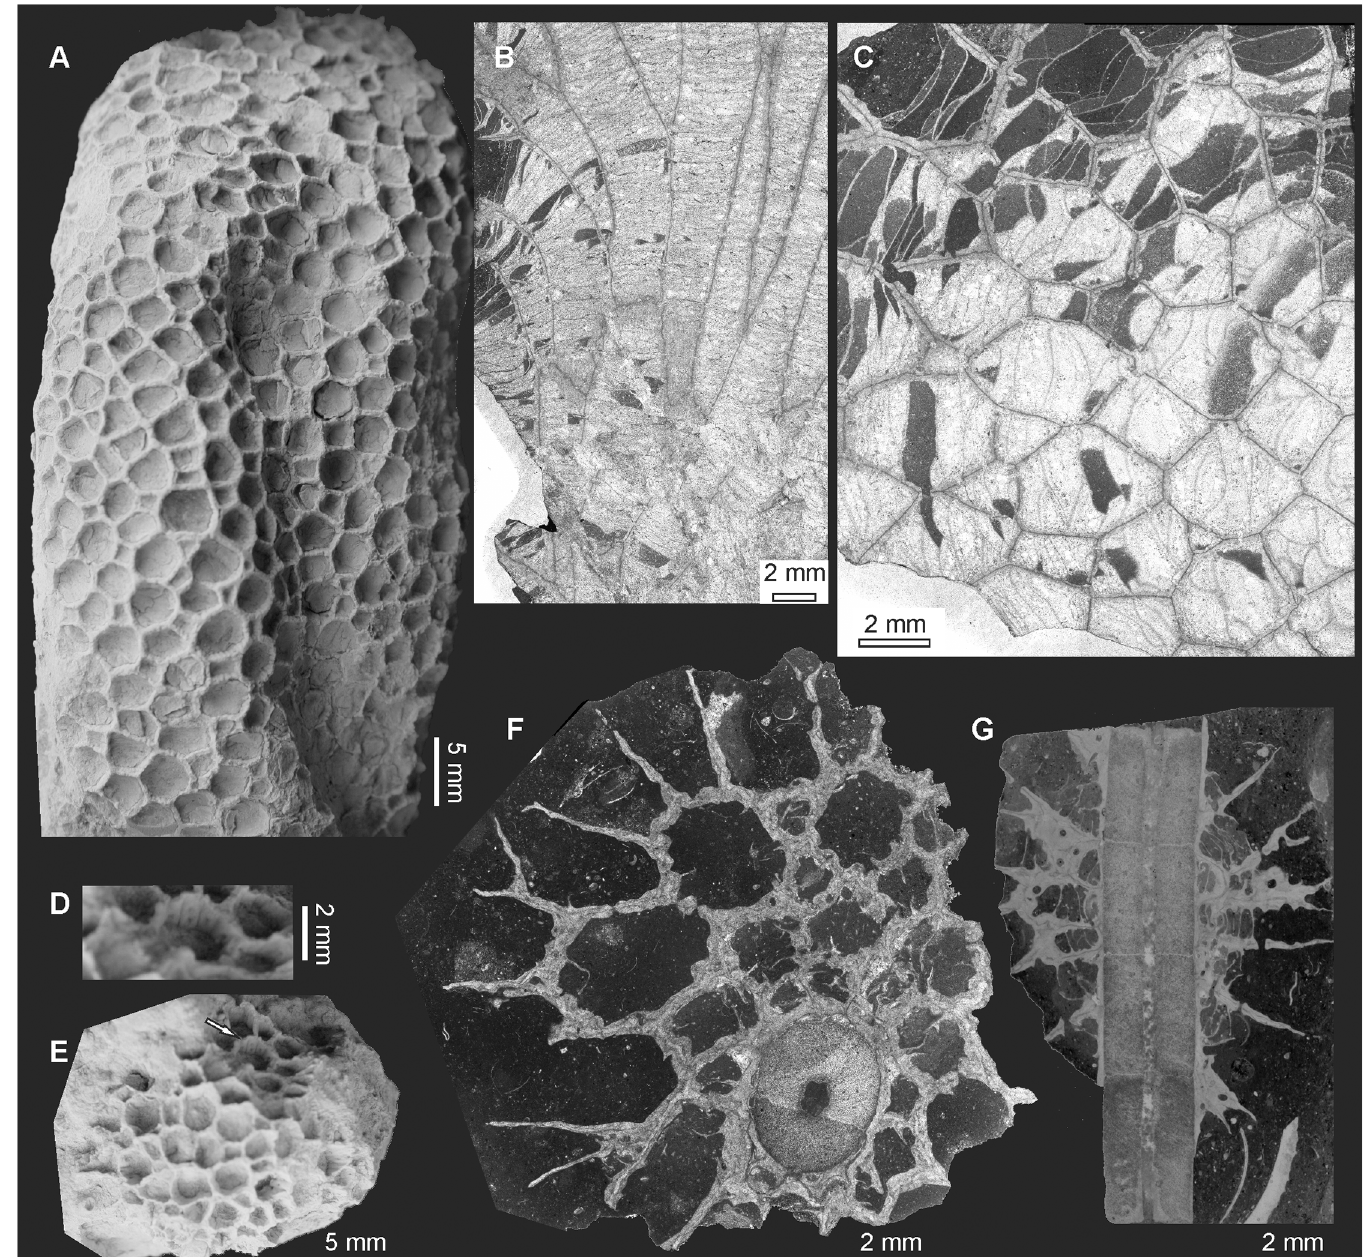
Fig 3. ? Favosites from Kowala Quarry, lithological set L, late Famennian. (A) ? Favosites sp. 1, external view of the corallum. (B) Favosites (?) sp. 1, longitudinal section through the corallum. (C) ? Favosites sp. 1, transverse section through the corallum. Specimen GIUS 3619 KF 002. (D) and (E) ? Favosites sp. 2 external view of the corallum. (D) shows the detail of (E), where the arrangement of mural pores is visible. (F) ? Favosites sp. 2, transverse section through the corallum. Specimen GIUS 3619 KF 104 (G) ? Favosites sp. 2, longitudinal section through the corallum encrusting a crinoid. Specimen GIUS 3619 KF